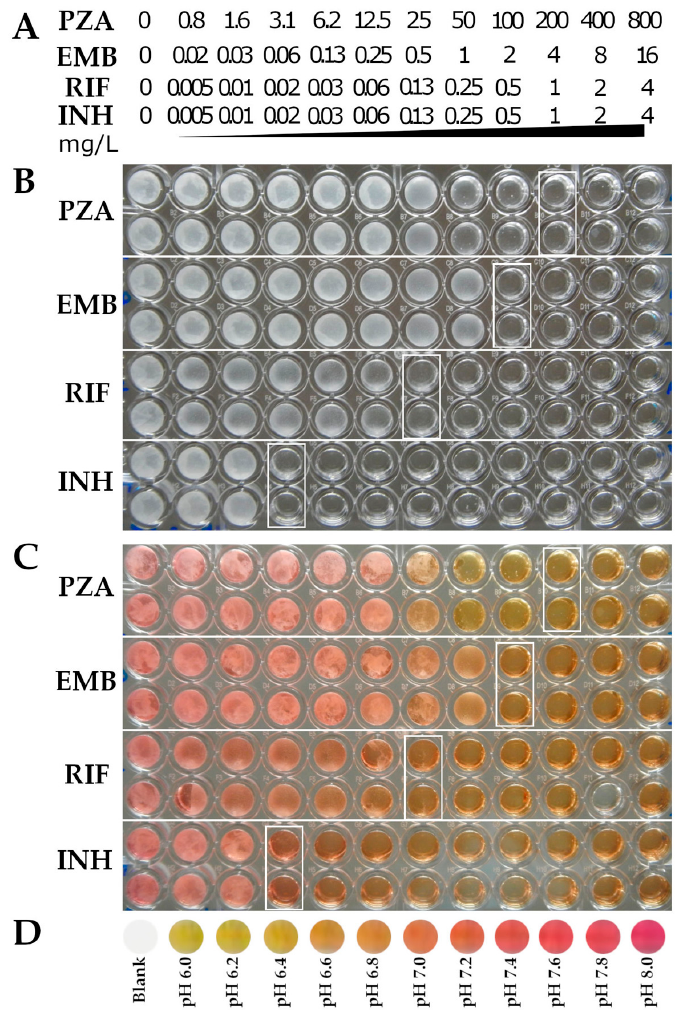
Figure 3. Determination of MICs of first-line TB drugs against M. tuberculosis and pH at 37 °C over 2 weeks at pH 6.8 in PZA-S1 minimal medium. ( A ), The concentrations of first-line TB drugs in the 96-well plate from wells 1 to 12 (PZA from 0 to 800 mg/L, EMB from 0 to 16 mg/L, RIF and INH from 0 to 4 mg/L). ( B ), No growth, labeled with white rectangular boxes on the microdilution plate for the first-line TB drug susceptibility tests in M. tuberculosis . ( C ), No growth, labeled with white rectangular boxes on the microdilution plate for the first-line TB drug susceptibility tests in M. tuberculosis and medium with phenol red at 15 mg/L. ( D ), Color standard of pH 6.0 to 8.0 with phenol red in PZA-S1 medium and blank control.